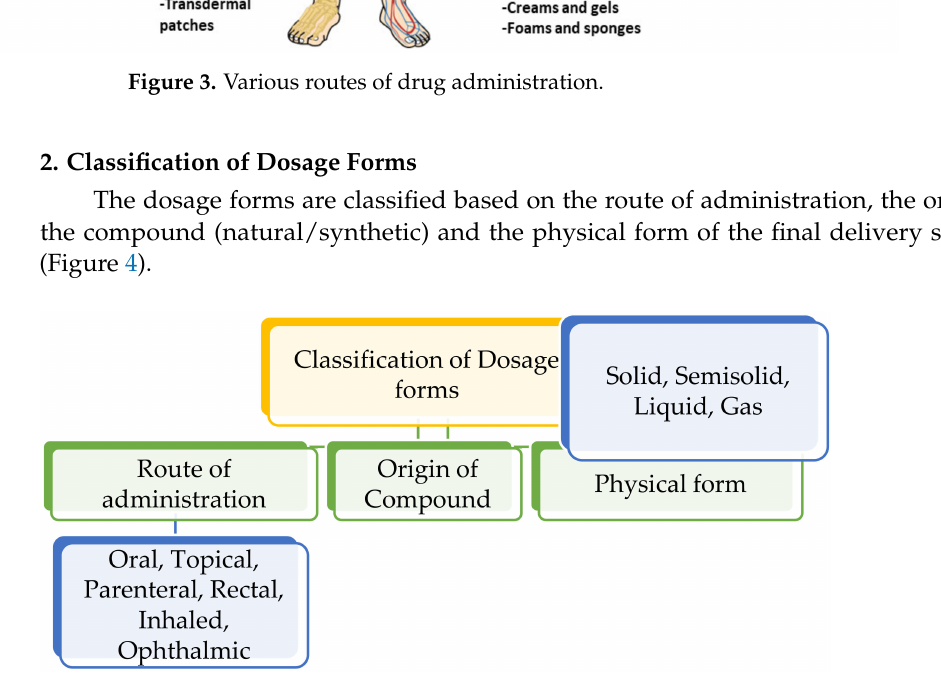
Figure 4. Classification of conventional dosage